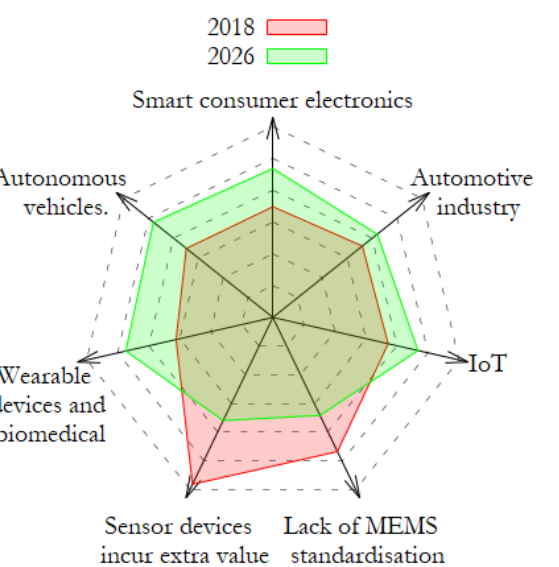
Figure 1. A chart showing the development of the top impacting factors on the global MEMS market from 2019 to 2026, predicted forecast data are taken from [2].